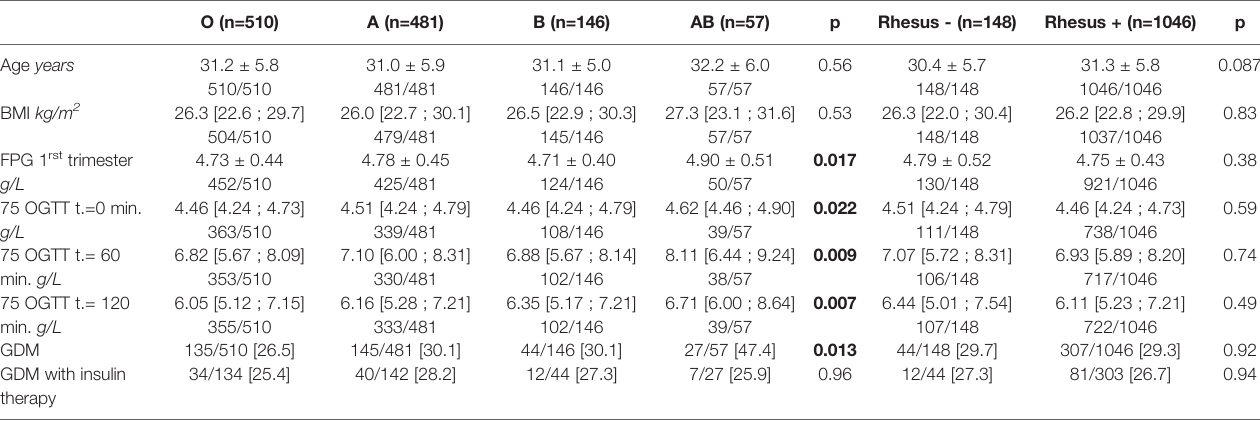
TABLE 2 | Characteristics of the study population during pregnancy, according to the ABO blood group and the Rh phenotype. O (n=510)